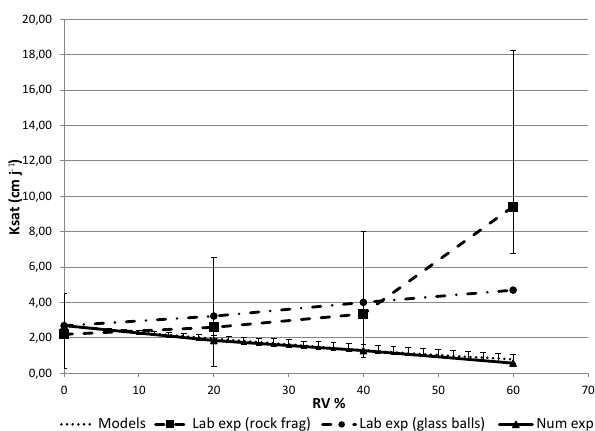
Fig. 2 – 𝐊 𝐬𝐞 depending on 𝐑 𝐯 obtained from laboratory experiments, numerical simulations Figure 2. K se depending on R v obtained from laboratory experi- with 12 circular inclusions and the predictive models (the bars show the maximum and ments, numerical simulations with 12 circular inclusions, and the minimum intervals around the median predicted by these models) predictive models (the bars show the maximum and minimum in- tervals around the median predicted by these